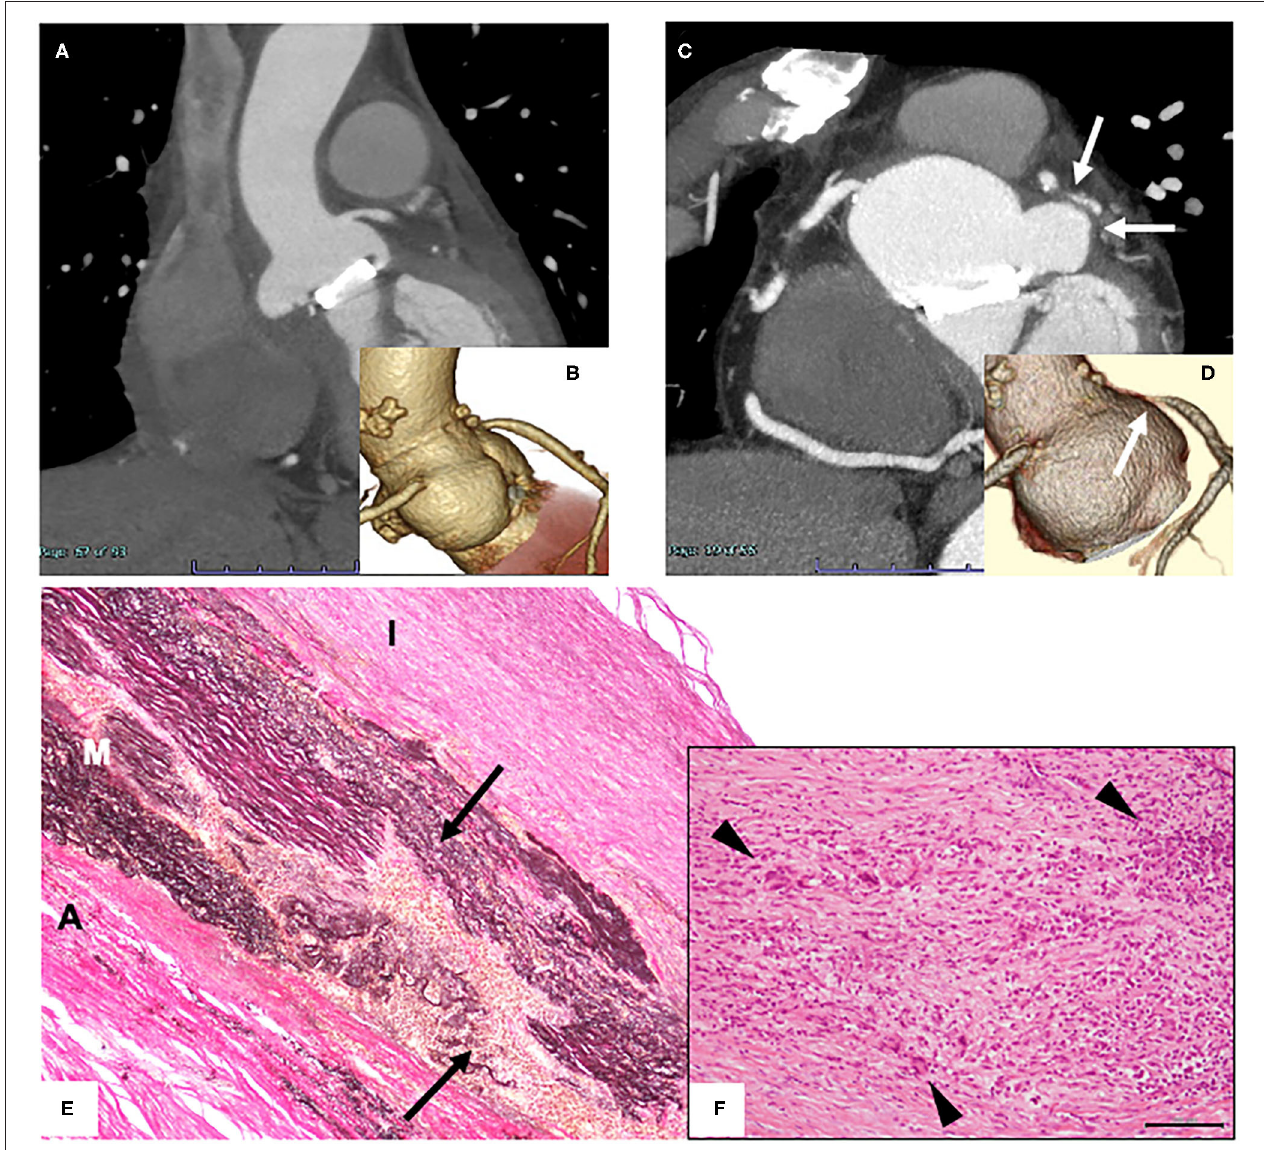
FIGURE 1 | (A,C) Contrast-enhanced computed tomography images 4 years ago (A) and on admission (C) . (B,D) 3D coronary angiography 4 years ago (B) and on admission (D) . (E,F) Histological findings of surgically resected tissue of the sinus of Valsalva. Images of Elastica von Gieson staining [ (E) ; original magnification 100x] and hematoxylin and eosin staining [ (F) ; original magnification 400x; scale bar, 100mm] are shown. A, adventitia; M, media; I, intima. Arrows indicate the site with disruption of elastic fibers in the medial layer. Arrow heads indicate giant